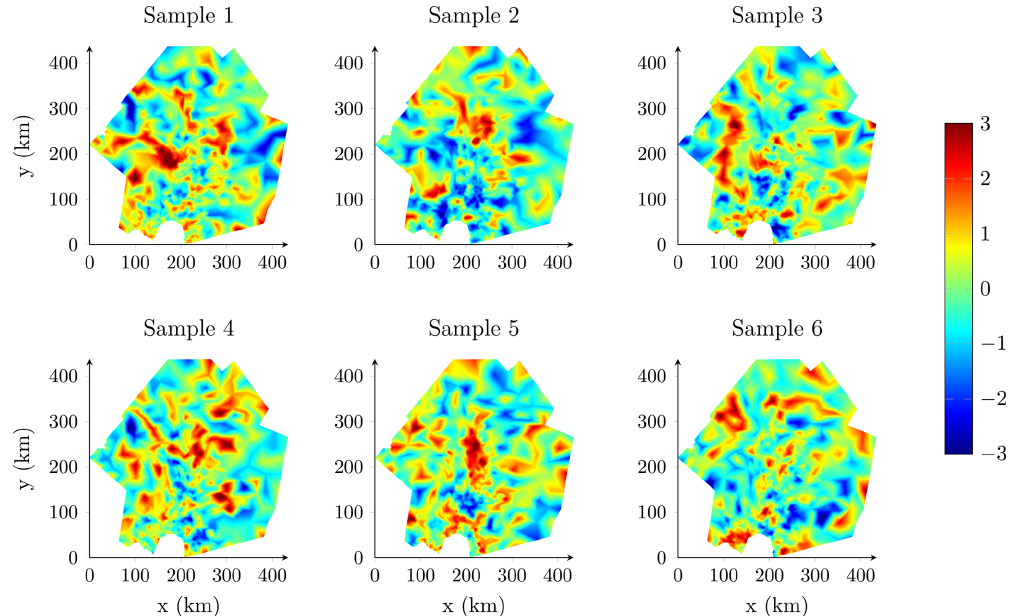
Figure 7. The same as Fig. 6 but with a parameter range of 30km. For comparison, the SPDE (Eq. 2) is solved with the same realizations of the right-hand side as in Fig.